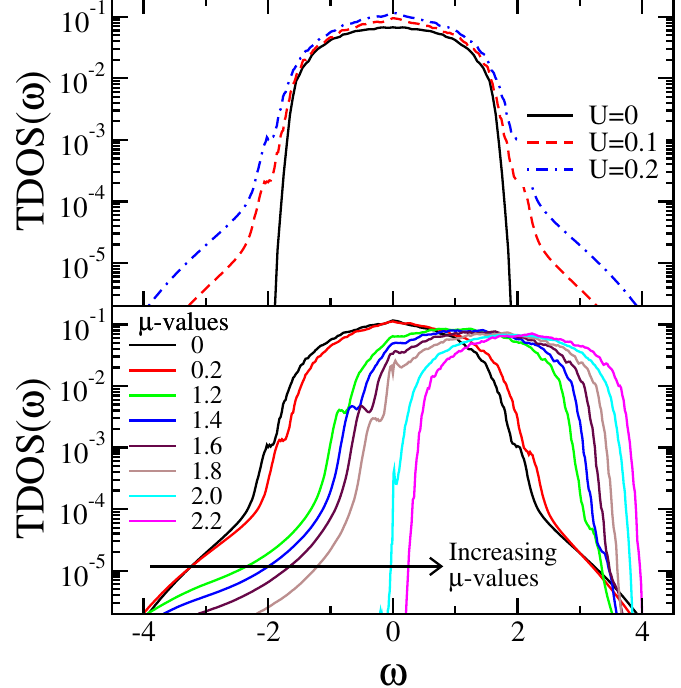
Figure 40. (Top) The typical DOS as a function of frequency, for the non-interacting case ( N c = 38, U = 0.0, units 4 t = 1) and two weakly interacting cases ( U = 0.1,0.2) are shown for a disorder value W that is close to the critical disorder, i.e., W / W c ( U ) = 0.86 [11] of the 3D Anderson-Hubbard model. The U = 0 TDOS shows a sharp band edge, while for U > 0, exponential tails are seen, indicating the broadening of the mobility edge. (Bottom) The typical DOS as a function of frequency, for the interacting case ( N c = 38, U = 0.2, units 4 t = 1) at various chemical potentials ( µ ). As the µ approaches the non-interacting mobility edge, the exponential tail seen in the top panel is replaced by a sharp